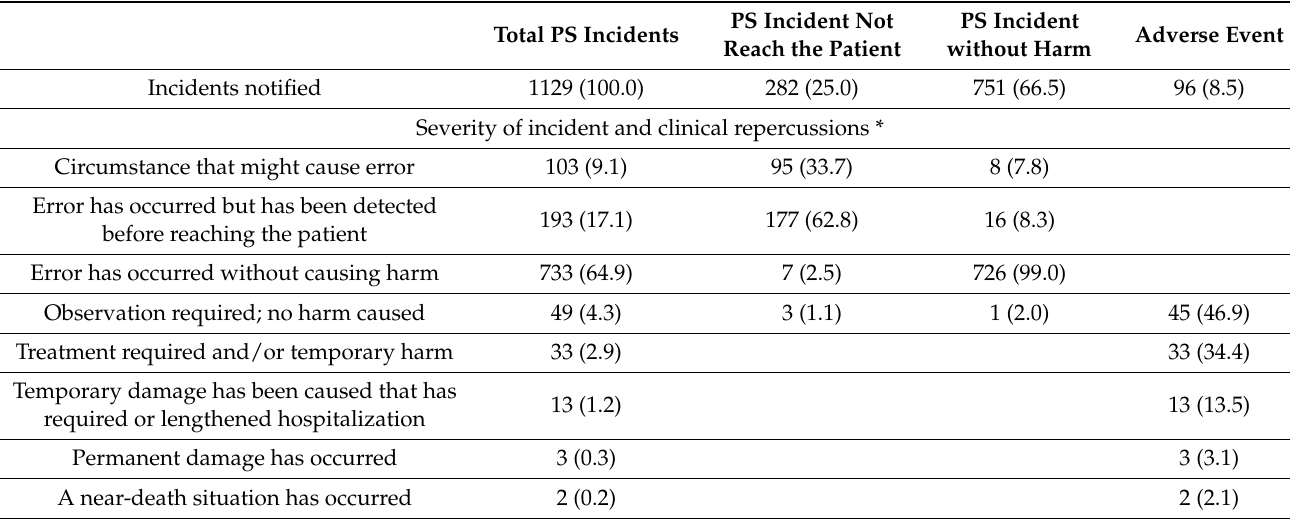
Figure 1. Flowchart illustrating how patient safety (PS) reports were selected, included, and excluded. Table 1. Distribution of type of incidents notified according to the severity and clinical